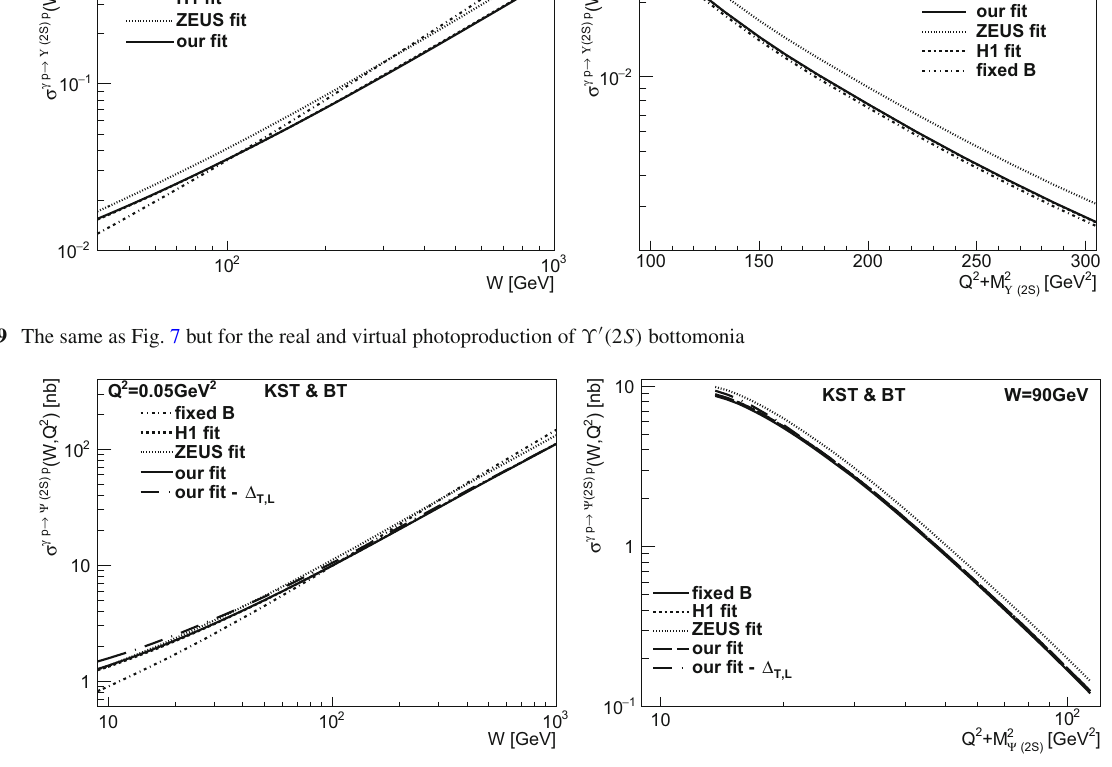
Fig. 10 The same as Fig. 7 but for the real and virtual photoproduction of ψ (cid:2) ( 2 S )